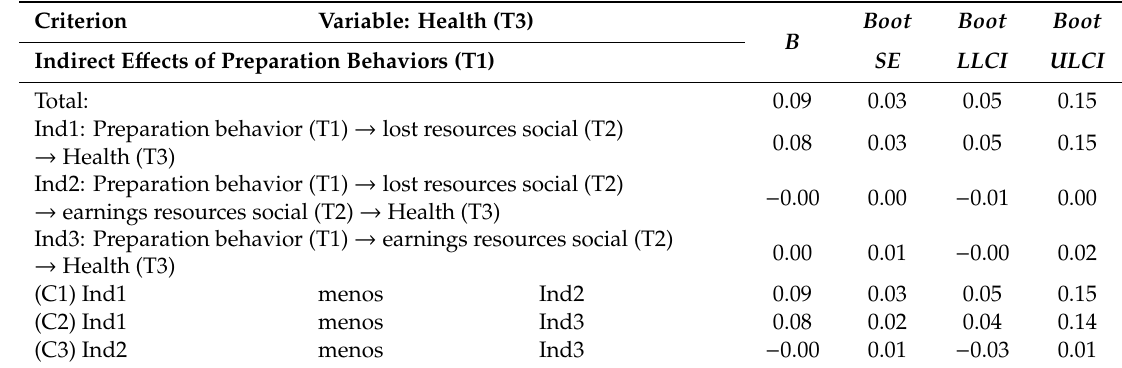
Table 12. Comparison of the indirect e ff ects of preparation behaviors (T1) through the losses (T2) and gains of social resources (T2) in the prediction of health (T3).